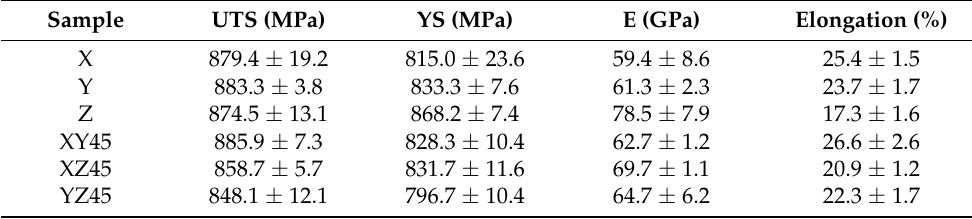
Figure 3. ( a ) Engineering stress–strain curves of Ti-55511 alloys. ( b ) The variations of the UTS, the YS, and the elongation at different samples. YS, and the elongation at different samples. Table 3. The mechanical properties of as-fabricated Ti-55511 alloys. Table 3. The mechanical properties of as-fabricated Ti-55511